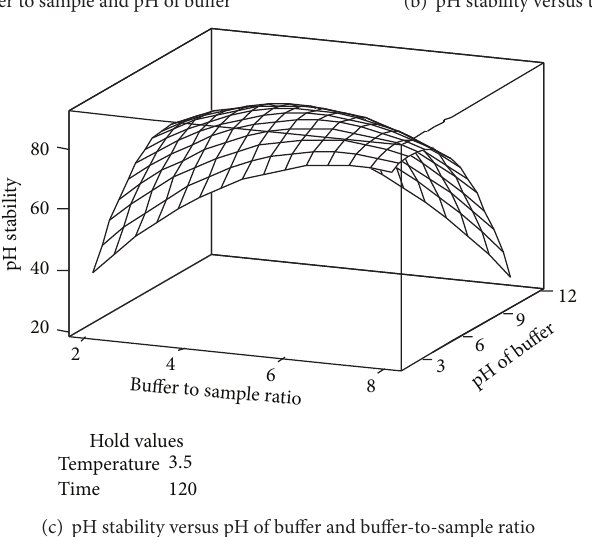
Figure 2: Three-dimensional surface plots for showing the significant interaction effect of independent extraction variables on temperature stability (a) and pH stability (b-c) of amylase were